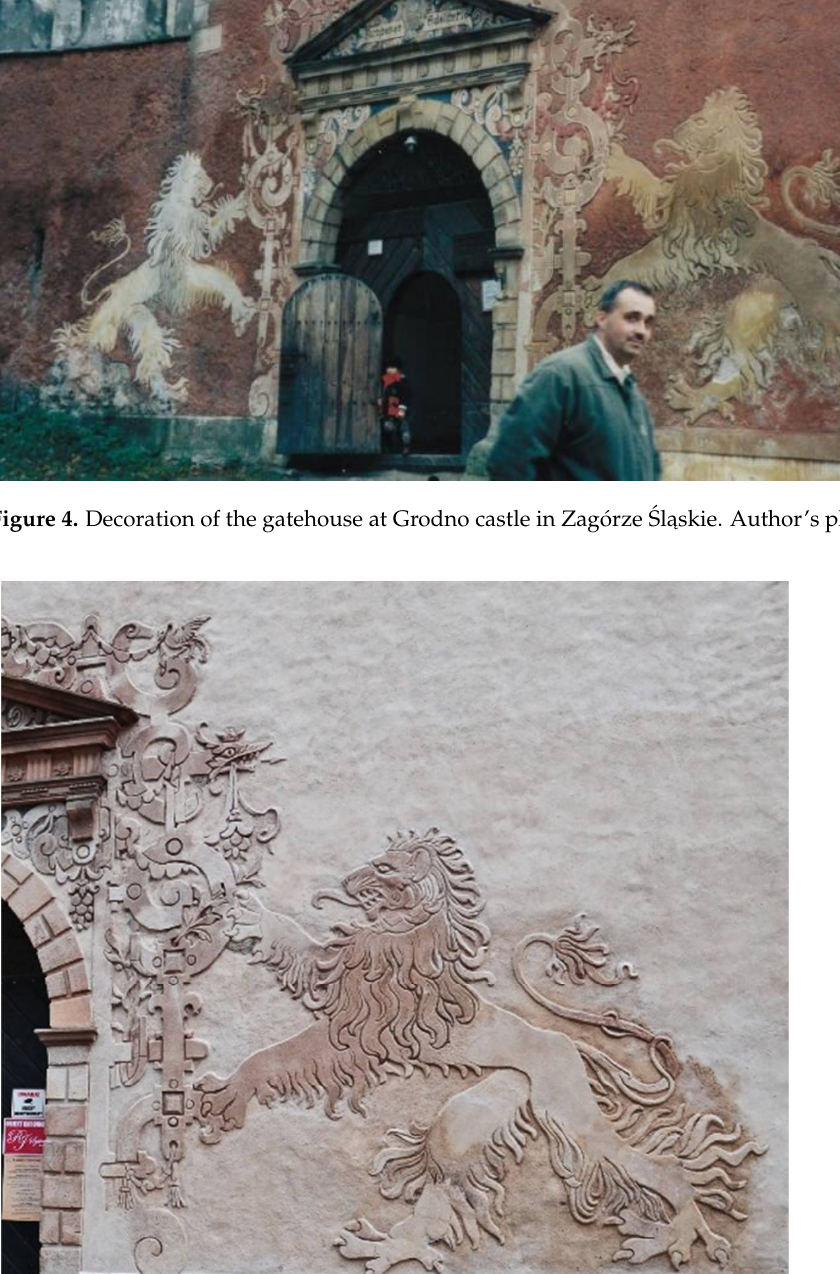
Figure 5. Fragment of decorations on Grodno castle in Zagórze Śląskie after conservation treatments carried out in 2014–2015. Author’s photo, 2003.